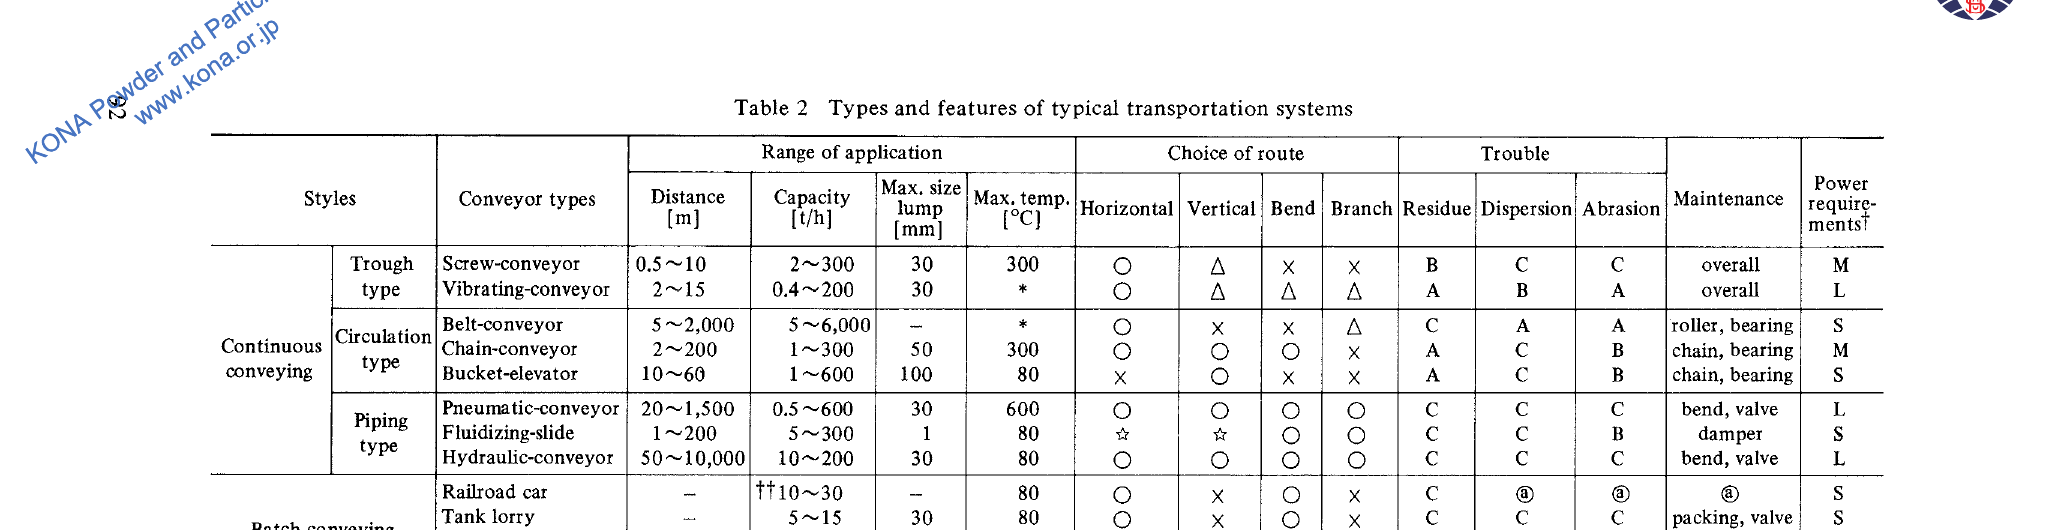
Table 3 Flow patterns of pneumatic